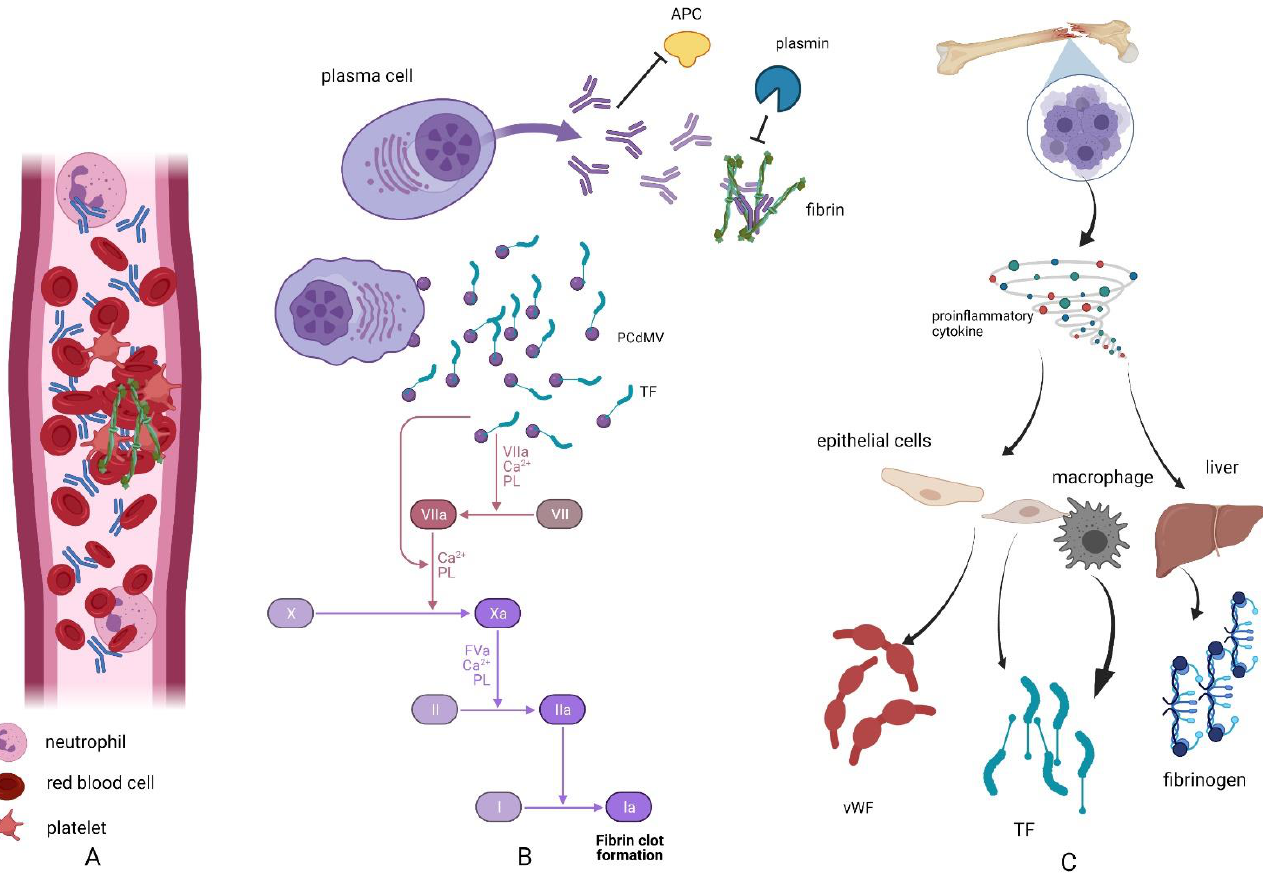
Figure 1. Mechanisms inducing hypercoagulability in plasma cell dyscrasias: ( A ) Extent of immunoglobulins in blood leads to hyperviscosity and a slowdown in blood flow, which in turn leads to platelet activation and the activation of coagulation. ( B ) Procoagulant effect of plasma cells is also associated with direct effect of monoclonal immunoglobulin on natural inhibitors of coagulation, leading to resistance to active protein C. Furthermore, plasma cells were found to release microvesicles baring tissue factor, which activates the extrinsic pathway of coagulation. In addition, monoclonal immunoglobulins attached to the thrombi block fibrinolysis. ( C ) Proliferation of monoclonal plasma cells in the bone marrow leads to overproduction of proinflammatory cytokines (i.e., interleukin 6 (IL-6), Tumor Necrosis Factor α (TNF-α)), which in turn stimulates production of procoagulation factors (fibrinogen in the liver, tissue factor in macrophages, and epithelial cells or von Willebrand factor in epithelial cells). APC, active protein C; vWF, von Willebrand factor; TF, tissue factor; PCdMV, plasma cell-derived microvesicles. The figure was generated using BioRender.com (22 September 2021).